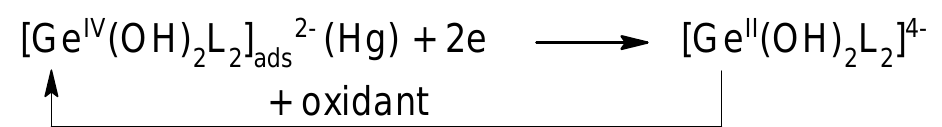
Scheme 1. Mechanism of the electrode processes responsible for the amplification of the Ge(IV) voltammetric signal in the presence of ligand (L) and